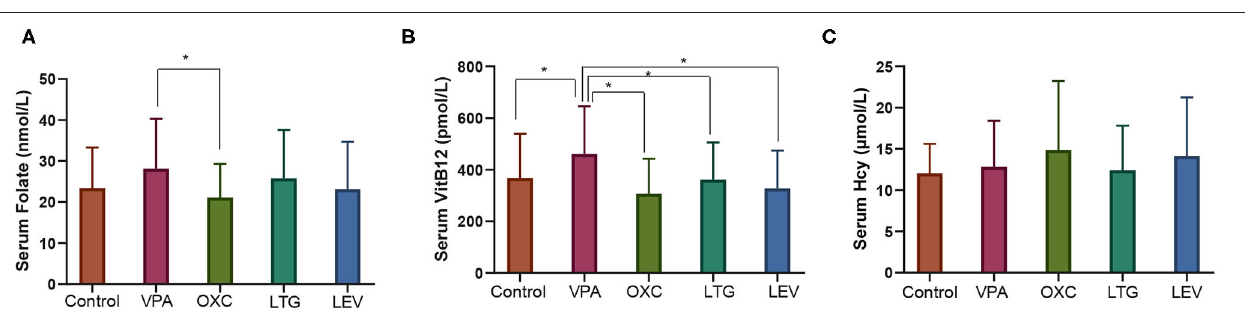
FIGURE 1 | Serum levels of one-carbon metabolites among groups of patients with epilepsy. (A) Serum FA levels, (B) serum VitB12 levels, and (C) serum Hcy levels. * P < 0.05. VPA, valproate; OXC, oxcarbazepine; LTG, lamotrigine; LEV, levetiracetam; N , number; vit B12, vitamin B12; Hcy,